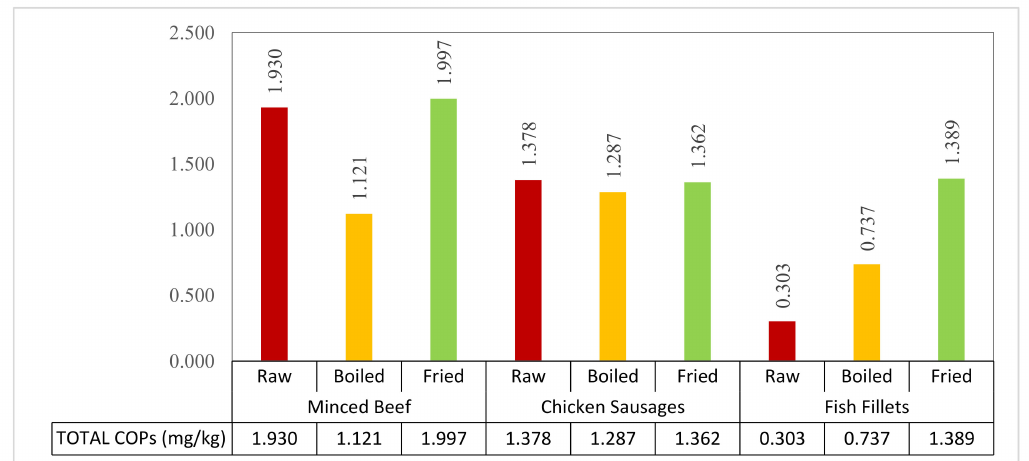
Figure 1. Total cholesterol oxidation product (COP) content (5 α -cholest + α -epoxy + β -epoxy + 25-HC + triol + 7-keto; mg / kg) for three di ff erent treatment types (raw, boiled, and fried) of minced beef, chicken sausages, and fish